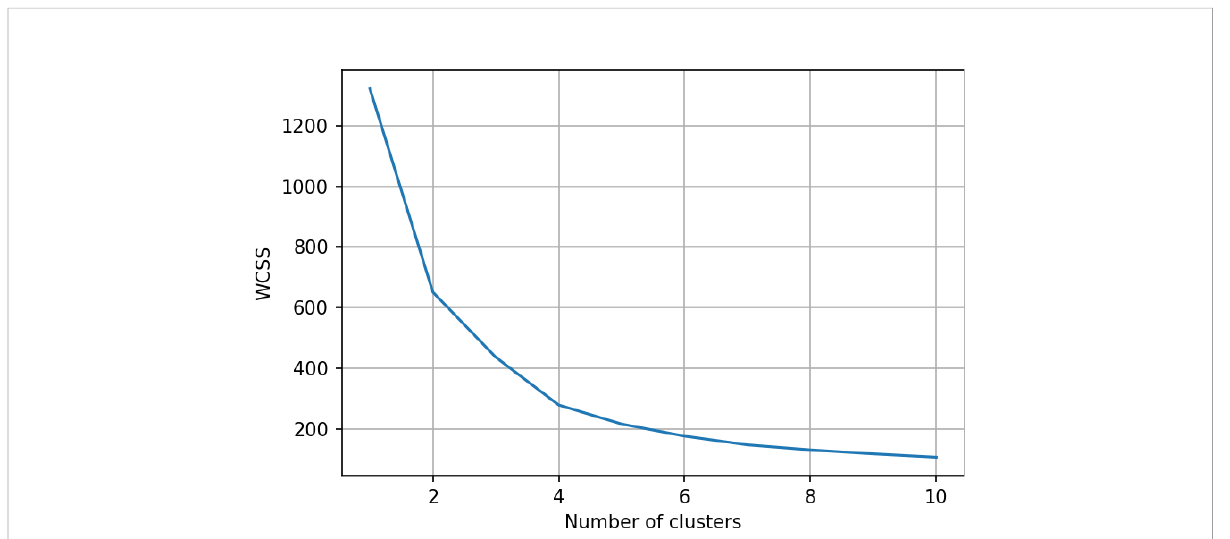
FIGURE 2 Elbow diagram indicating the performance for different pre-de fi ned numbers of clusters. The in fl exion point indicates the optimum number of clusters. This corresponds to the 2-variable model